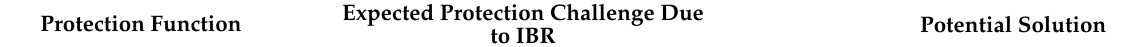
Table 2. Summary of the main findings regarding the impact of IBRs on system